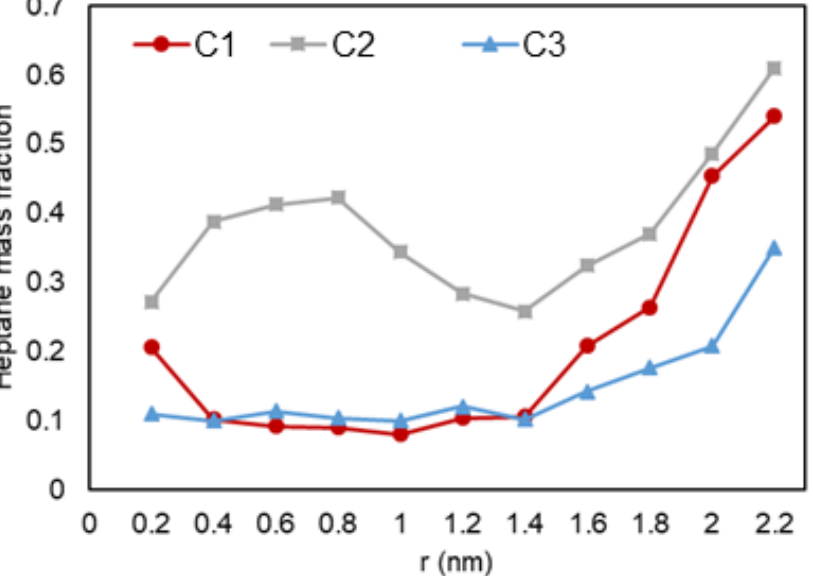
Figure 14. Images at the pore entrance of C1 ( a ), C2 ( b ), and C3 ( c ) conditions simulations. Yellow and white colors are heptane and ethane molecules, respectively.